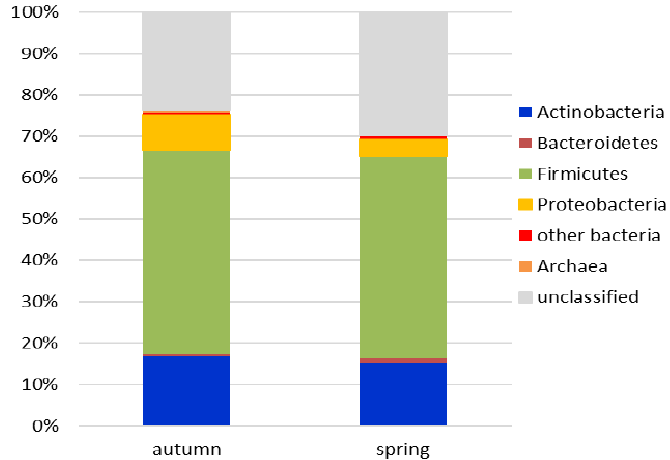
Figure 1. The average relative abundance (%) of the sequences identified at phylum level in samples of Edam cheese.